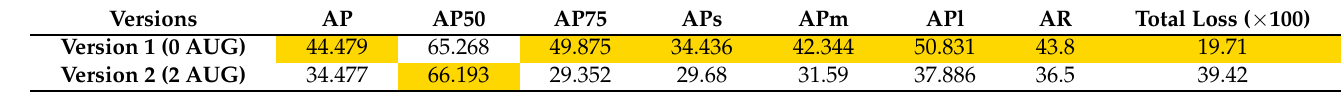
Table 17. Detectron2 metrics obtained with the second model. Each column refers to a different metric, as defined in Section 2.4.2. Each row refers to a different version of the model.